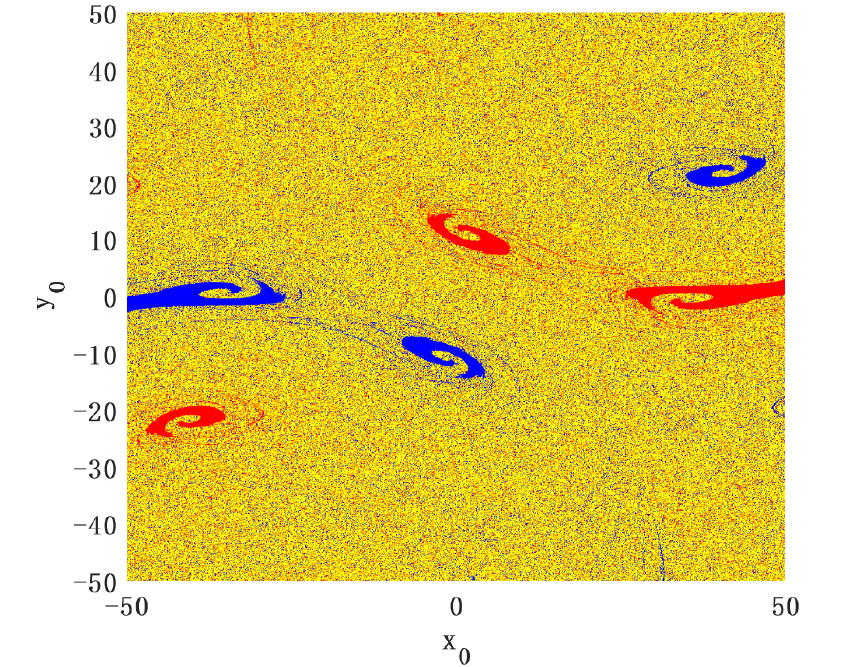
Figure 13. Basins of attraction in the x ( 0 ) – y ( 0 ) initial plane with z ( 0 ) = w ( 0 ) =